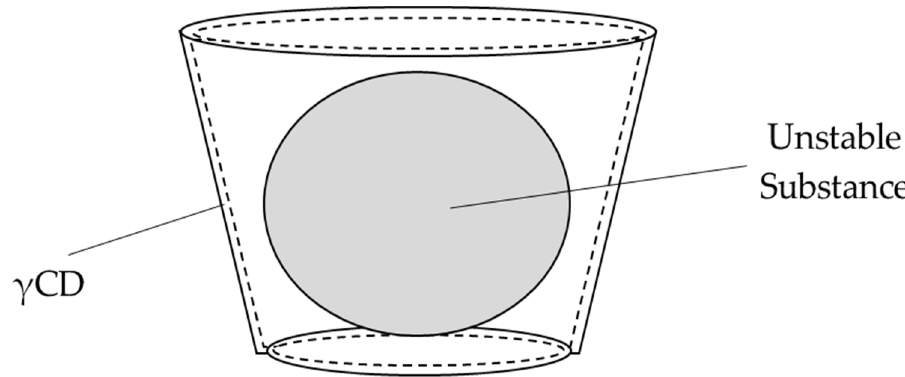
Figure 2. Illustration of γ -cyclodextrin inclusion.